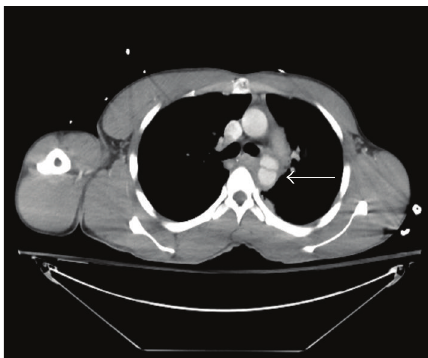
Figure 1: Aortic injury with pseudoaneurysm noted in the region of the ligamentum arteriosum. Hematoma is also noted surrounding the distal aortic arch and the descending thoracic aorta.